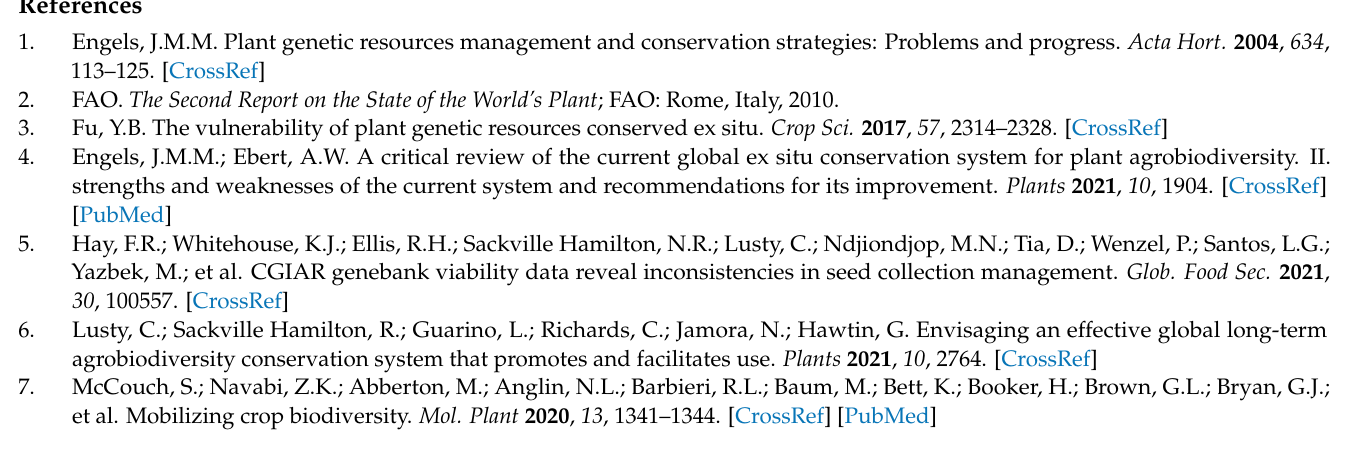
Figshare DOI (https://doi.org/10.6084/m9.figshare.22143443). A. List of excel files for 12 germplasm APD data sets and five other supplementary files. B. Supplementary Materials and methods.